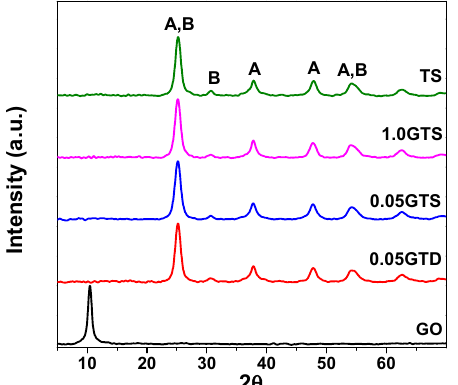
Figure 3. XRD patterns of starting GO, pure TiO 2 (TS) and GT composite materials prepared at 100 °C by dynamic (0.05GTD) and statistic methods (0.05GTS and 1.0GTS). A and B represent the characteristic peaks of anatase and brookite phases, respectively.